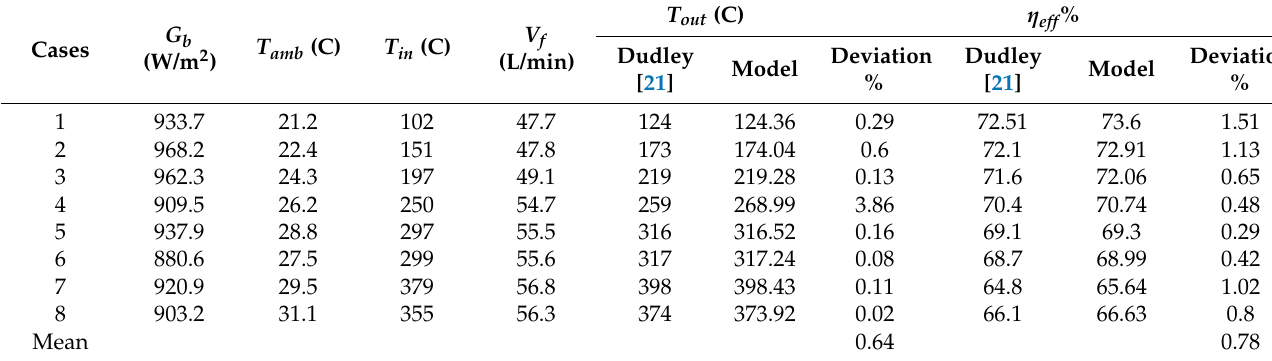
Table 6. Validation model with SNL outlet temperature and efficiency results